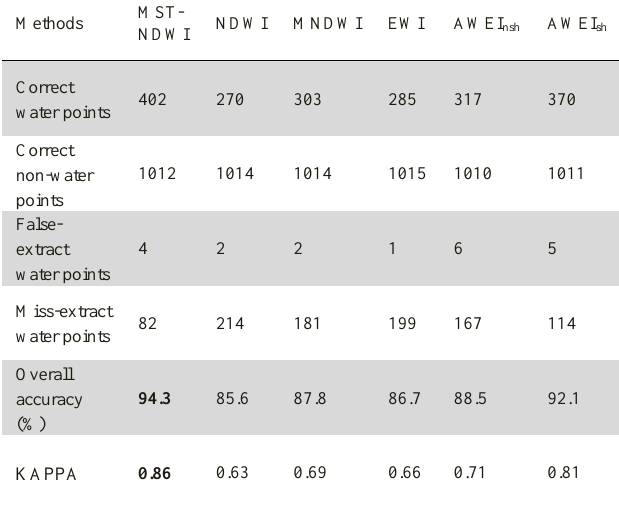
Table 2. The accuracy assessment results of MST-NDWI and the conventional water indexes such as NDWI, MNDWI, EWI, and AWEI, showing MST-NDWI reached the highest overall